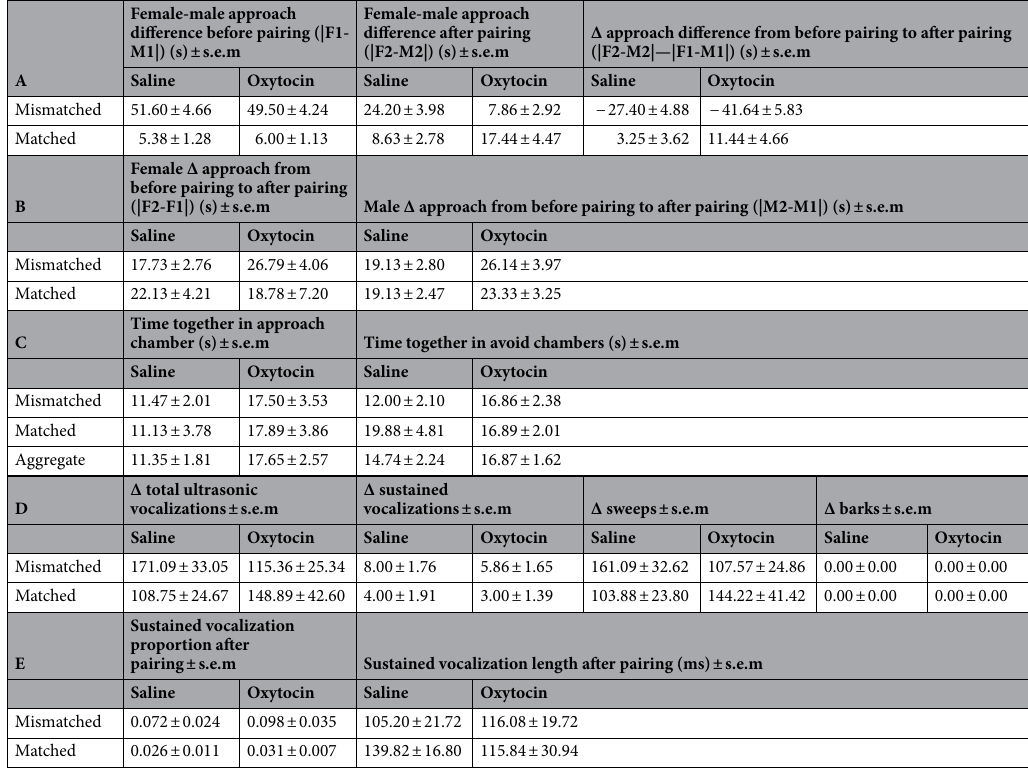
Table 1. Descriptive table of mean group values. ( A ) Approach differences between paired mates. ( B ) Approach differences for individuals. ( C ) Time spent together by pairs. ( D ) Changes in aggregate vocalizations from before pairing to after pairing. ( E ) Proportion of ultrasonic vocalizations that were sustained vocalizations after